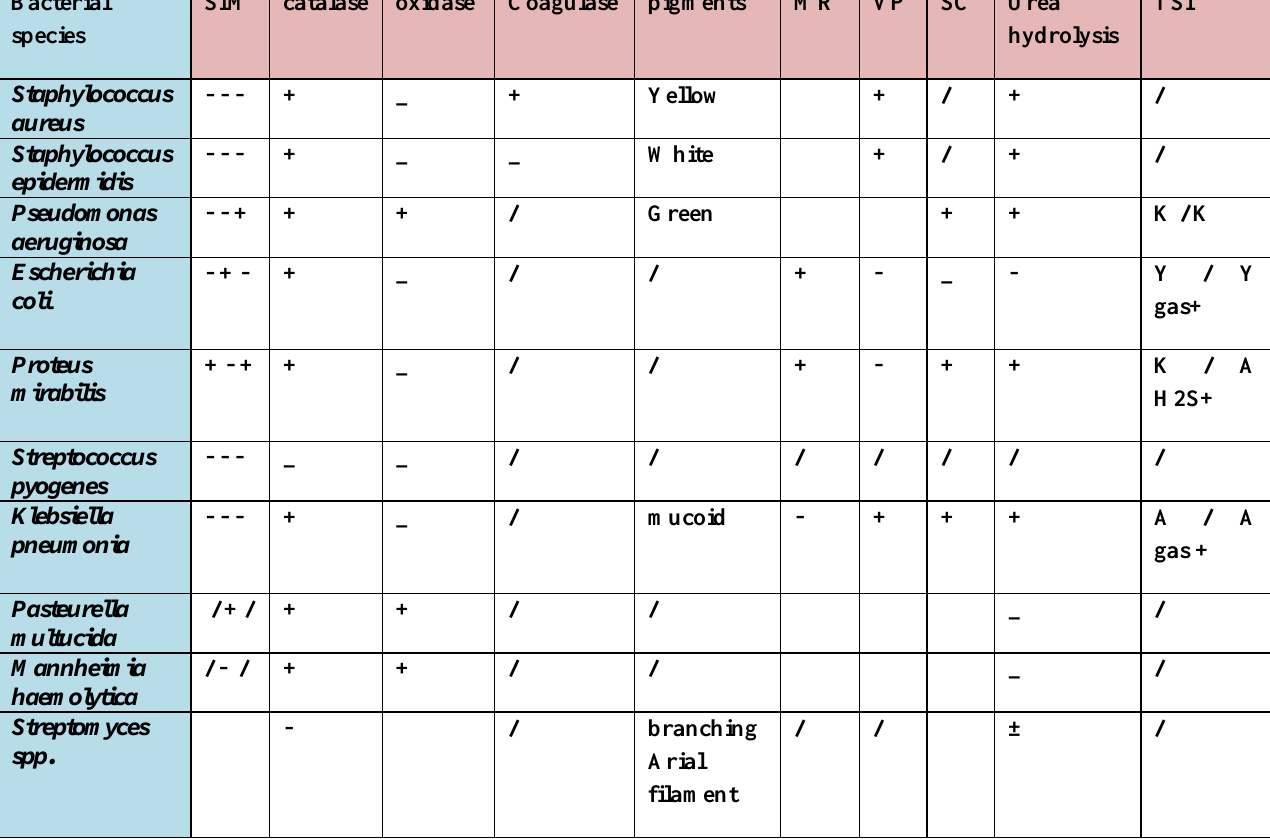
Table:7 Biochemical tests were include: Biochemical test for bacterial species isolates from otitis externa in sheep